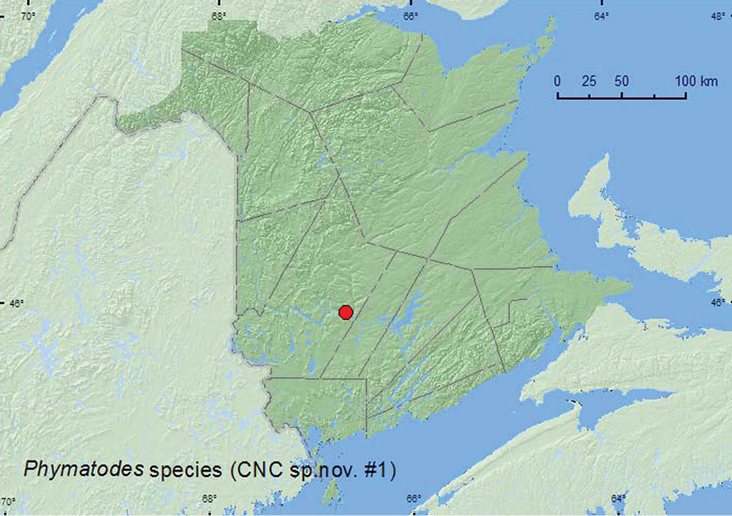
 Collection localities in New Brunswick, Canada of Phymatodes species (CNC sp. n. #1).